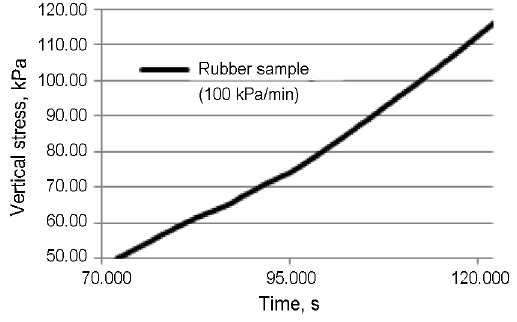
Fig. 14. Controlled vertical stress ramp (rubber compression from 50.0 to 120.0 kPa) versus time